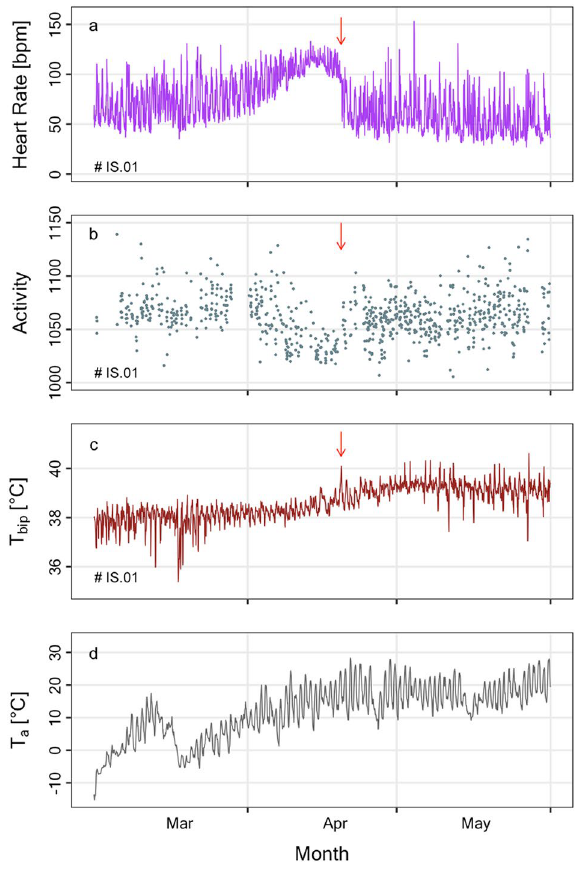
Figure 2. Example for the time courses of hourly means of ( a ) heart rate, ( b ) activity, ( c ) intraperitoneal temperature (T bip ) and ( d ) ambient temperature (T a ) early in the year (2018-03-01–2018-05-31). All physiological variables were measured in the same female (IS.01). The red arrows indicate times when the female had a suddenly decreasing HR, resumed activity, and had a spike in body temperature, presumably at